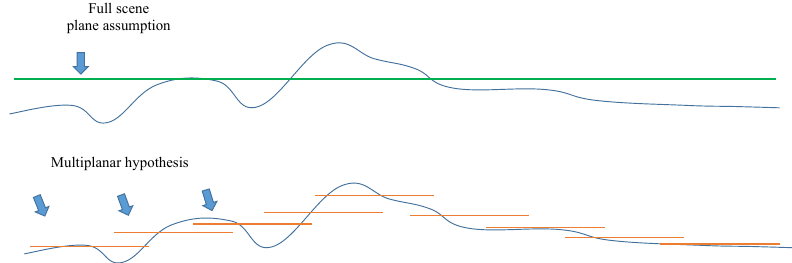
Figure 2. Blue curve represents the real terrain, green line represents the full-scene plane assumption, and orange lines represent multiplanar